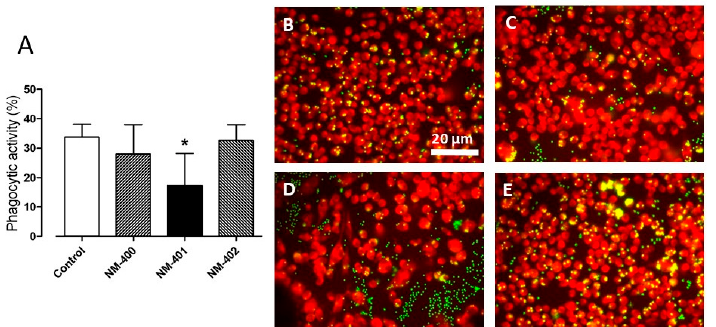
Figure 5. Effects of NM-400, NM-401, and NM-402 on the phagocytic activity. Raw264.7 macrophages were seeded on coverslips and, after a 24 h-exposure to 10 µ g / cm 2 of the indicated MWCNT, phagocytic activity determined as described in the Materials and Methods. ( A ) Data are expressed as the % of phagocytic activity and are the means ± SD ( n = 3). * p < 0.05 vs. control cells, as determined with the t -test for unpaired data. ( B – E ) Images of representative fields taken with a fluorescence microscope. ( B ) Control, untreated cells. ( C) NM-400-treated cells. ( D ) NM-401-treated cells. ( E ) NM-402-treated cells.